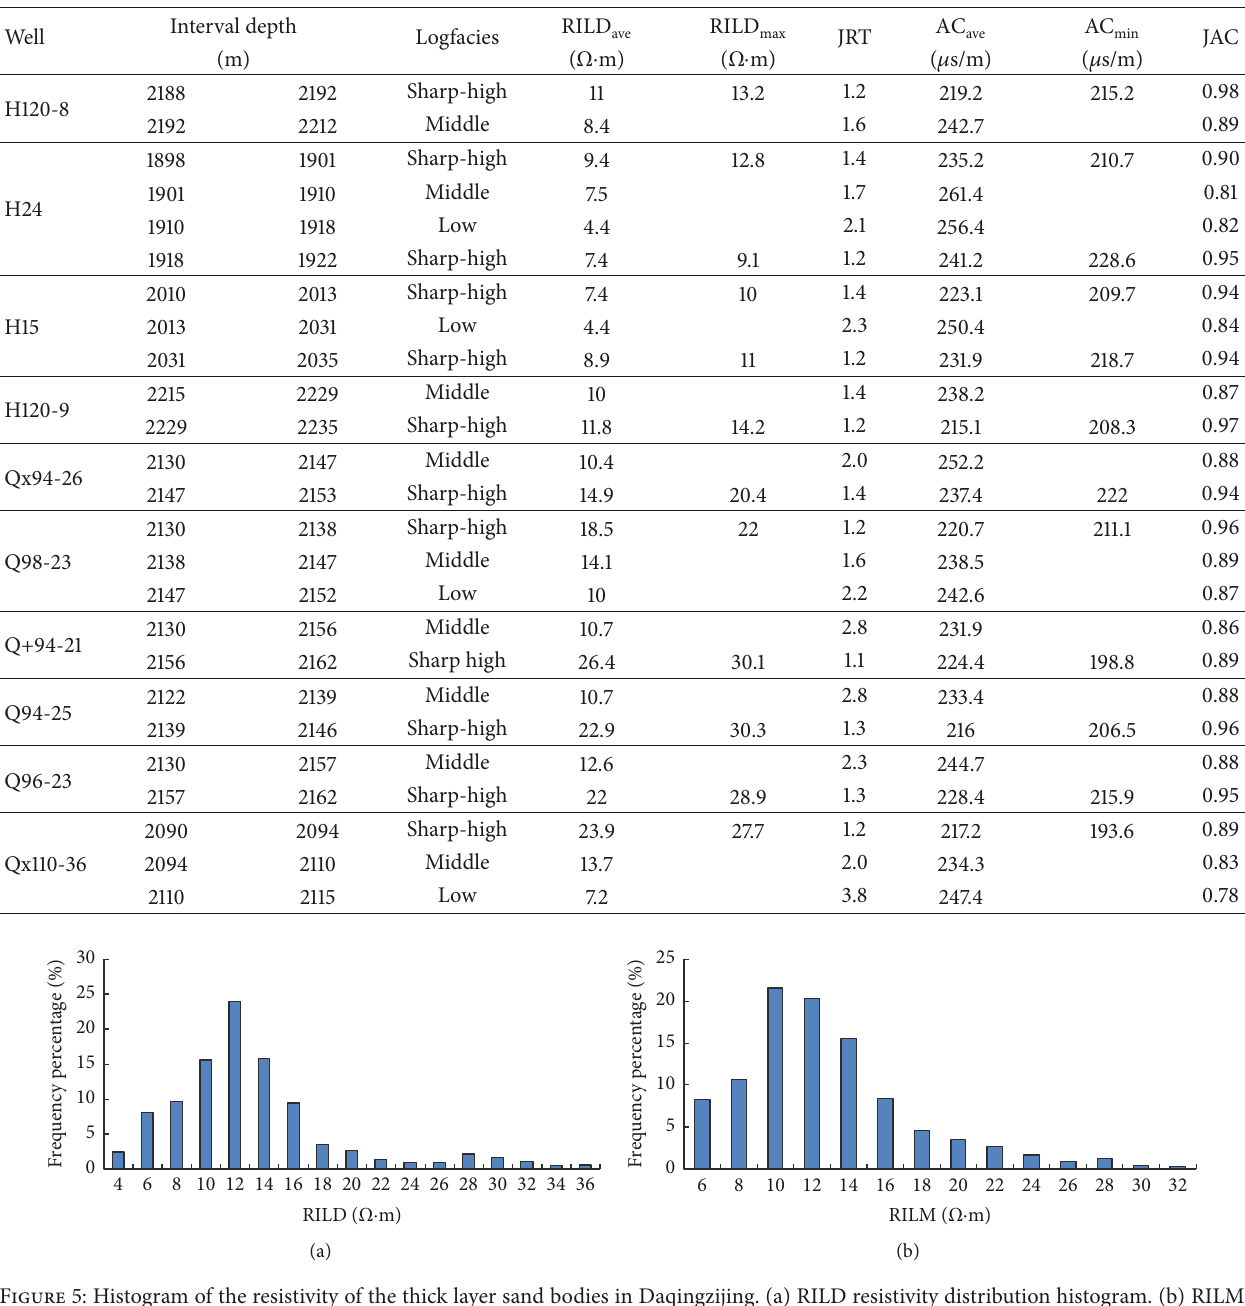
Table 1: Response value of different curve types of thick layer sand bodies.